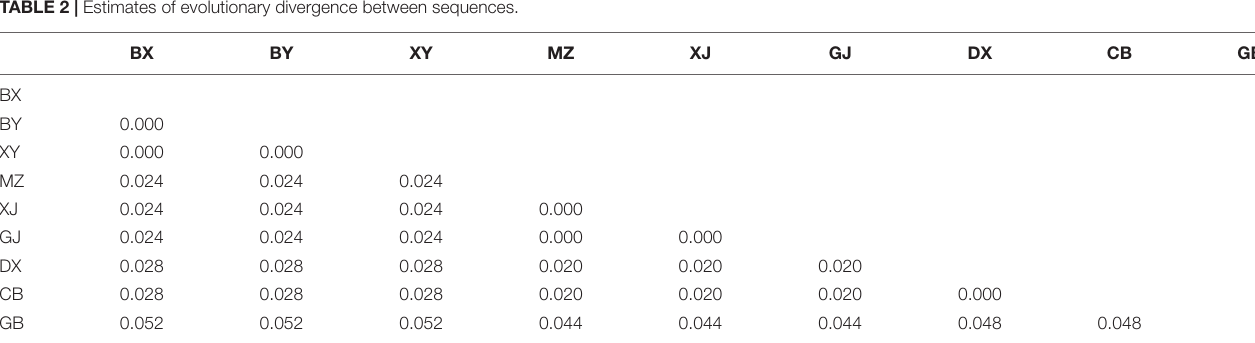
FIGURE 2 | Molecular phylogenetic analysis of Pimacao origin plants. (A) Molecular phylogenetic analysis by the maximum-likelihood method based on the Tamura-Nei model. (B) Evolutionary relationships of taxa were inferred using the neighbor-Joining method. The percentage of replicate trees in which the associated taxa clustered together in the bootstrap test (1,000 replicates) is shown next to the branches. TABLE 2 | Estimates of evolutionary divergence between